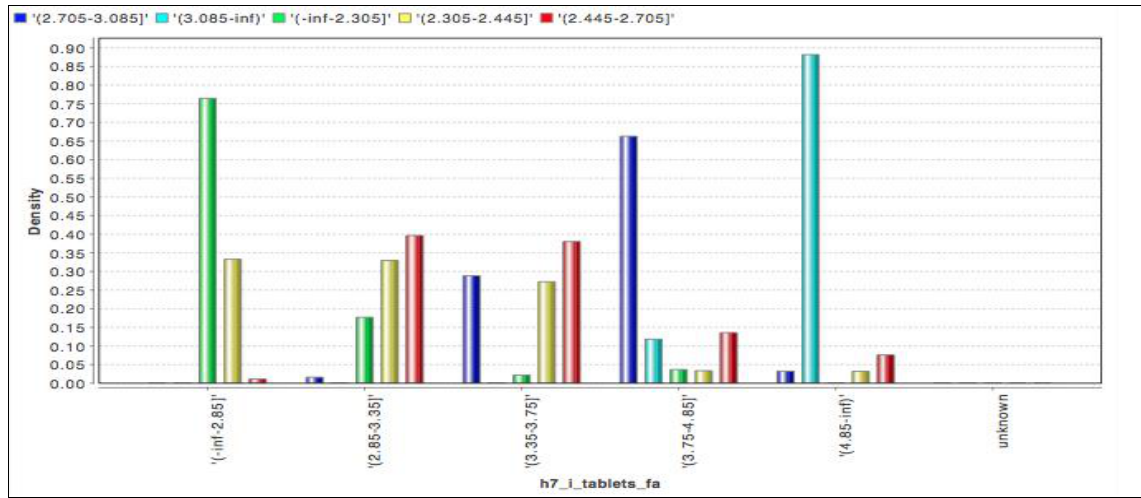
Figura 10. Densidad de probabilidad de intervalos discretos de THDv con relación a la corriente del 7º